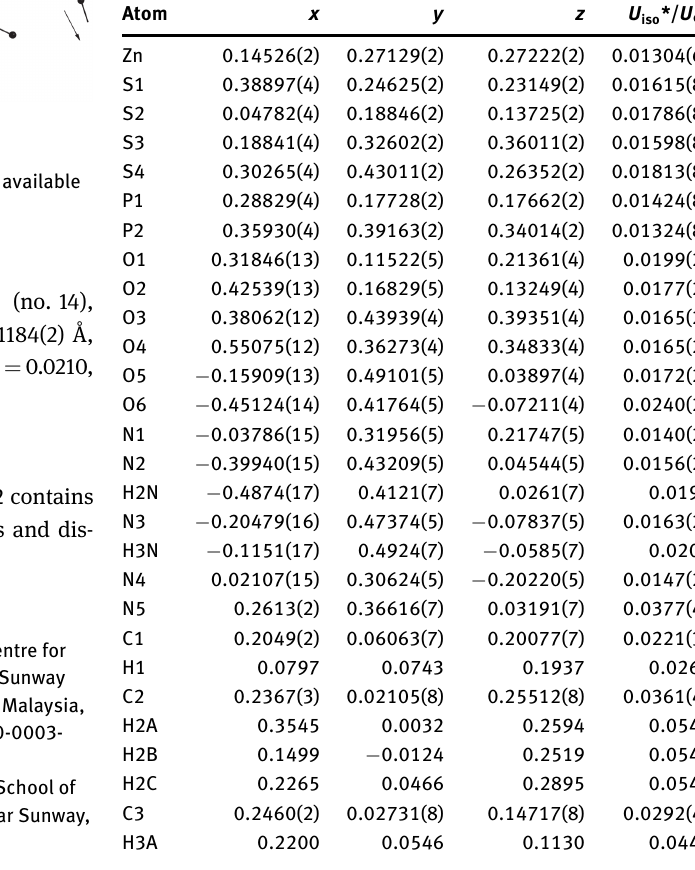
Table 2: Fractional atomic coordinates and isotropic or equivalent isotropic displacement parameters (Å 2